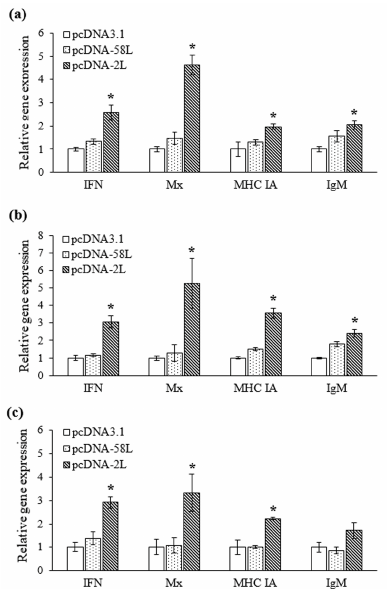
Figure 4. qRT-PCR analysis of the expression of type I IFN , Mx , MHC IA , and IgM genes in liver ( a ), spleen ( b ), and kidney ( c ) tissues from vaccinated Chinese giant salamanders. The mRNA level of each gene was normalized to that of β -actin . For each gene, the mRNA level of the control Chinese giant salamander (pcDNA3.1 group) was set as 1. Asterisks indicate significant differences from the control group. Data are presented as means ± SE ( n = 3). * p < 0.05.